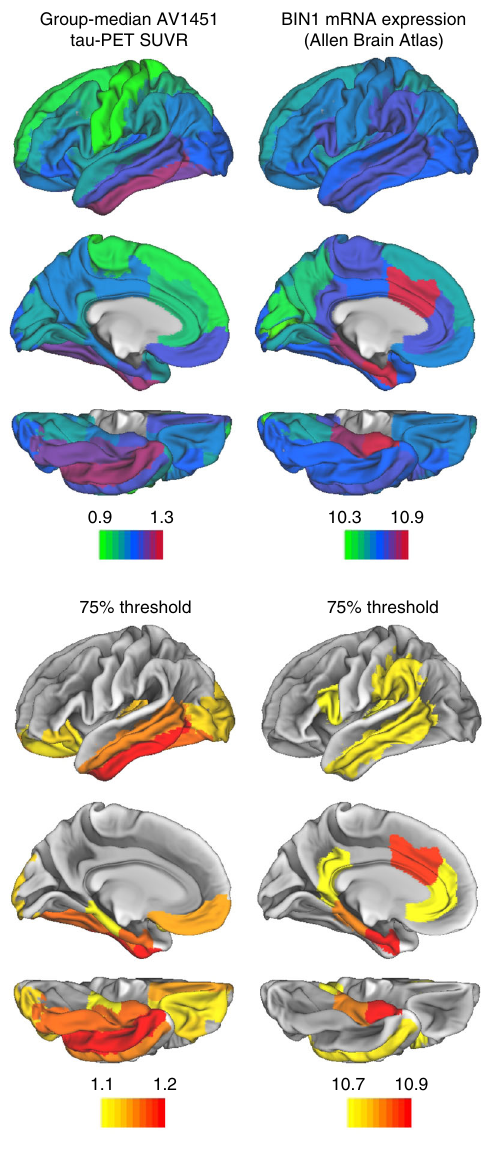
Fig. 4 Spatial patterns of tau-PET and BIN1 mRNA expression. Spatial mapping of median BIN1 mRNA expression (i.e., log 2 ) derived from the Allen Brain Atlas and group-median AV1451 tau-PET SUVR (derived from n = 89 subjects), either for all ROIs (upper panel) or restricted to regions falling above the 75 th percentile of either BIN1 mRNA expression or group- median AV1451 tau-PET uptake (lower panel). Color scales represent SUVR scores for AV1451 tau-PET and log 2 mRNA expression for BIN1 mRNA